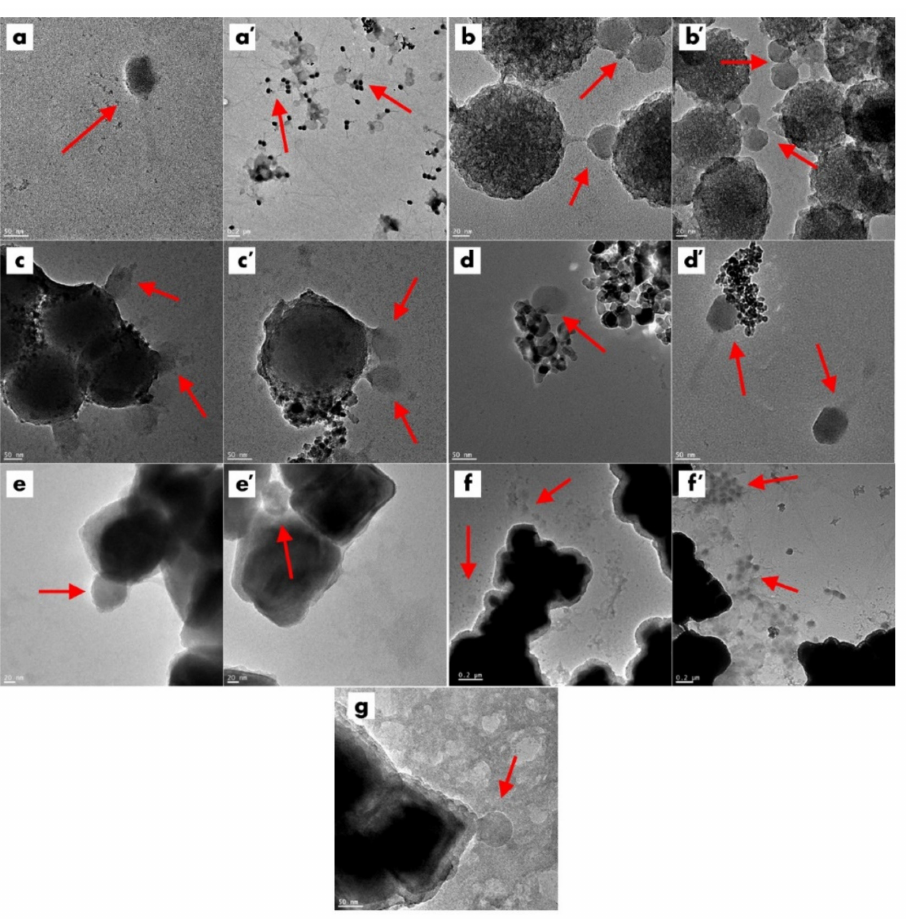
Figure 5. TEM micrographs of bacteriophage T4 5 ( a , a’ ) and of phage–nanoparticle interactions ( b – g ). Red arrows point to the phage particles. SiO 2 and phage ( b , b’ ), TiO 2 -SiO 2 and phage ( c,c’ ), TiO 2 and phage ( d , d’ ), Fe 3 O 4 and phage ( e , e’ ), SiO 2 -Fe 3 O 4 -TiO 2 and phage ( f , f’ ), Fe 3 O 4 -SiO 2 and phage ( g